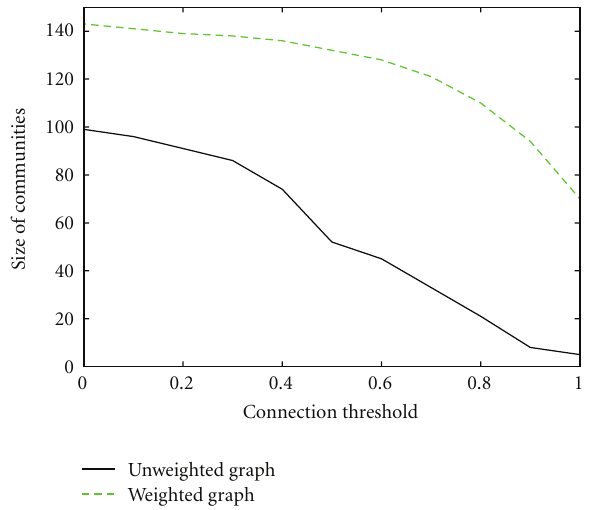
Figure 8: Size of communities on the MovieLens dataset, according to the connectivity threshold θ